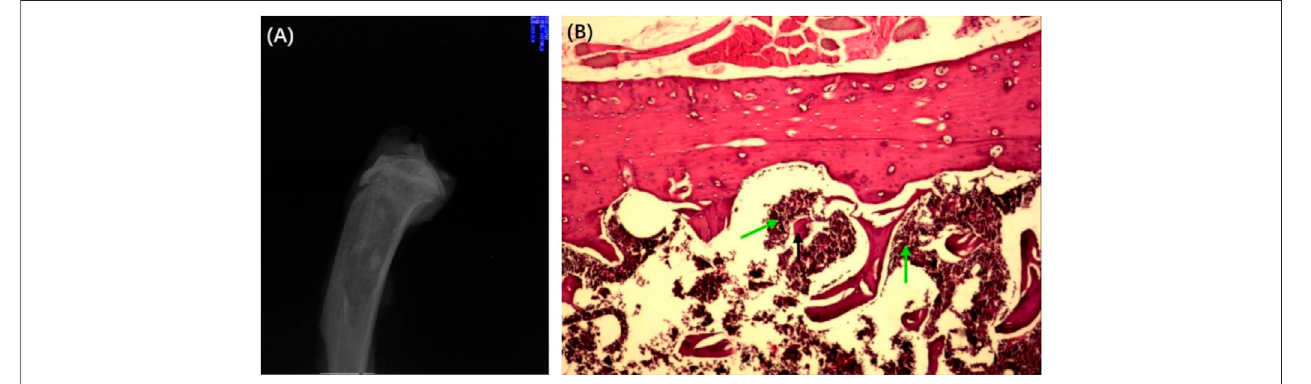
FIGURE 7 | X-ray (A) and HE-stained section (B) of the chronic osteomyelitis model. Black arrows: deadbone; green arrows: in fl ammatory cells.